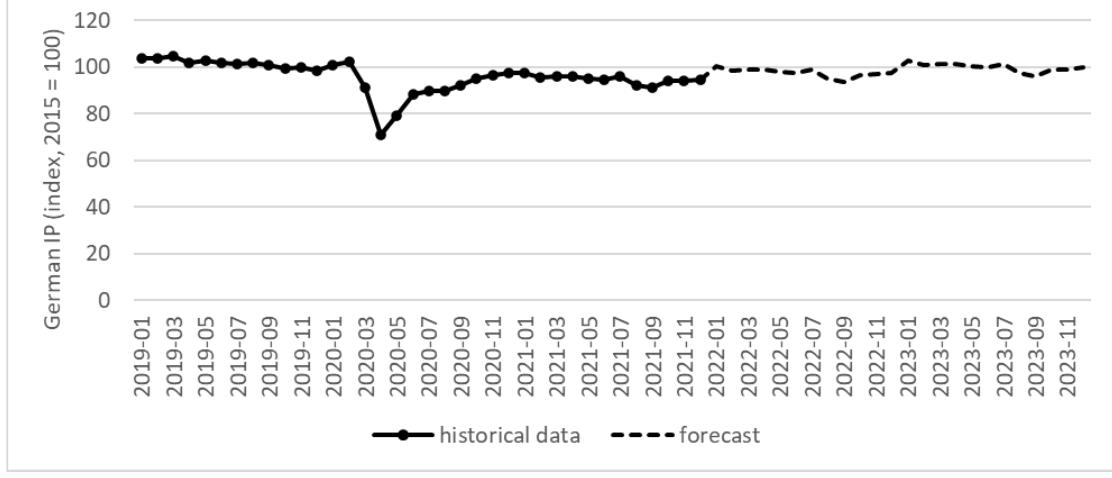
Figure 6. Forecast IP Germany (2019, 2021 historical data, 2022-2023 forecast) Source: own composition based on Trading economics (2022)